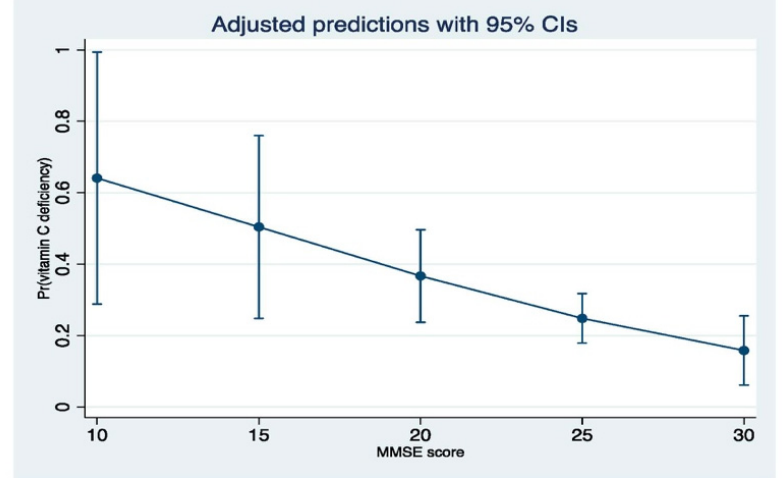
Figure 2. Prediction probability of vitamin C deficiency according to MMSE scores.